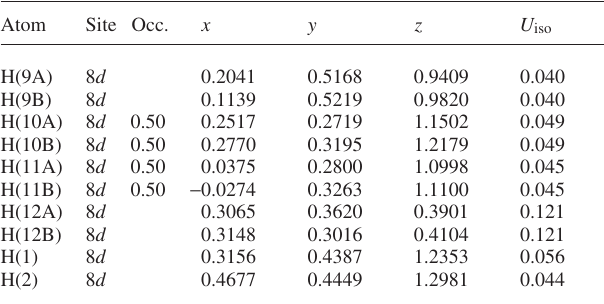
Table 2. Atomic coordinates and displacement parameters (in Å 2 )